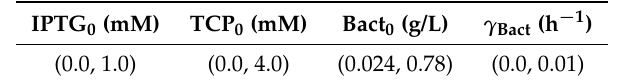
Table 1. Results of robustness monitoring for Property 7. A simple table presents the relevant ranges of initial conditions (i.e., the concentration of variables and setting of parameters) which robustly violate Property